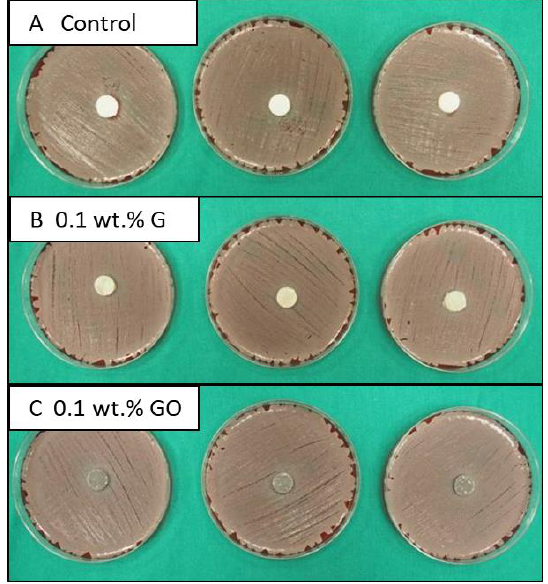
Figure 5. Photographs showing the extent of antimicrobial activity for the ( A ) control, ( B ) 0.1 wt.% G-PMMA bone cement, and ( C ) 0.1 wt.% GO-PMMA bone cement when in contact Staphylococcus aureus for an incubation period of 24 h.